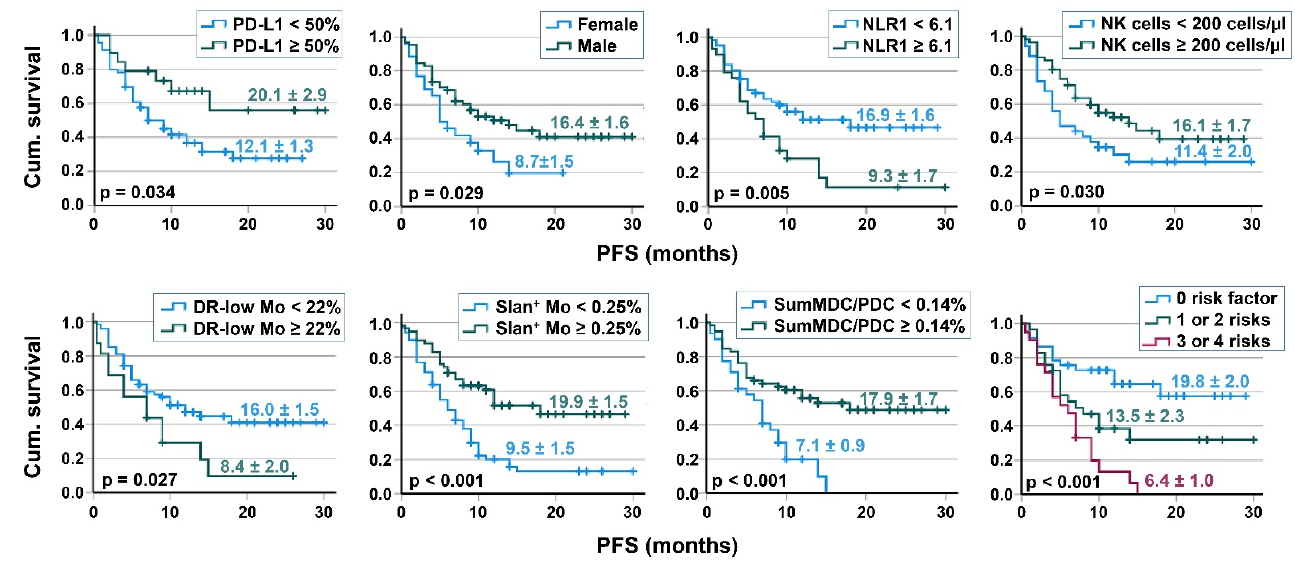
Figure 2. Relationship between risk factors/baseline immune cell parameters and patients’ PFS.